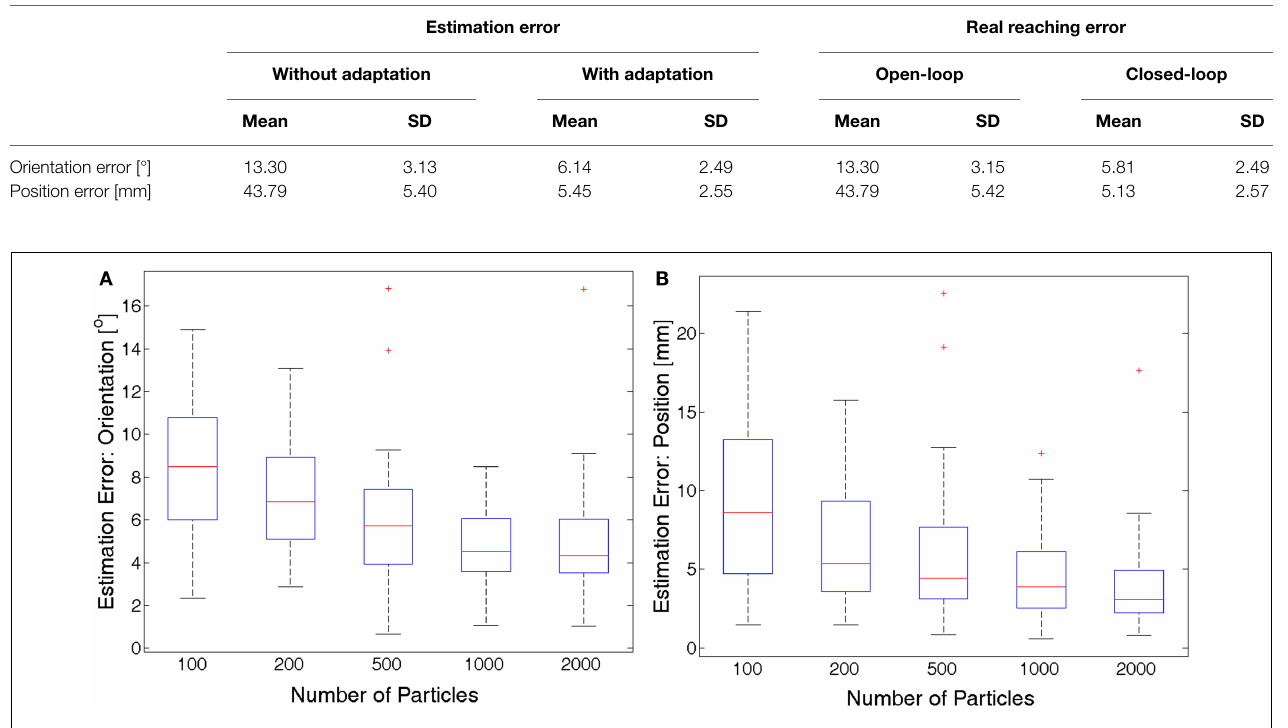
TABLE 1 | Estimation and real reaching errors in the final poses of each movement: the estimation errors and the real reaching errors of open-loop are computed at frame 120, in the final pose of the open-loop phase .